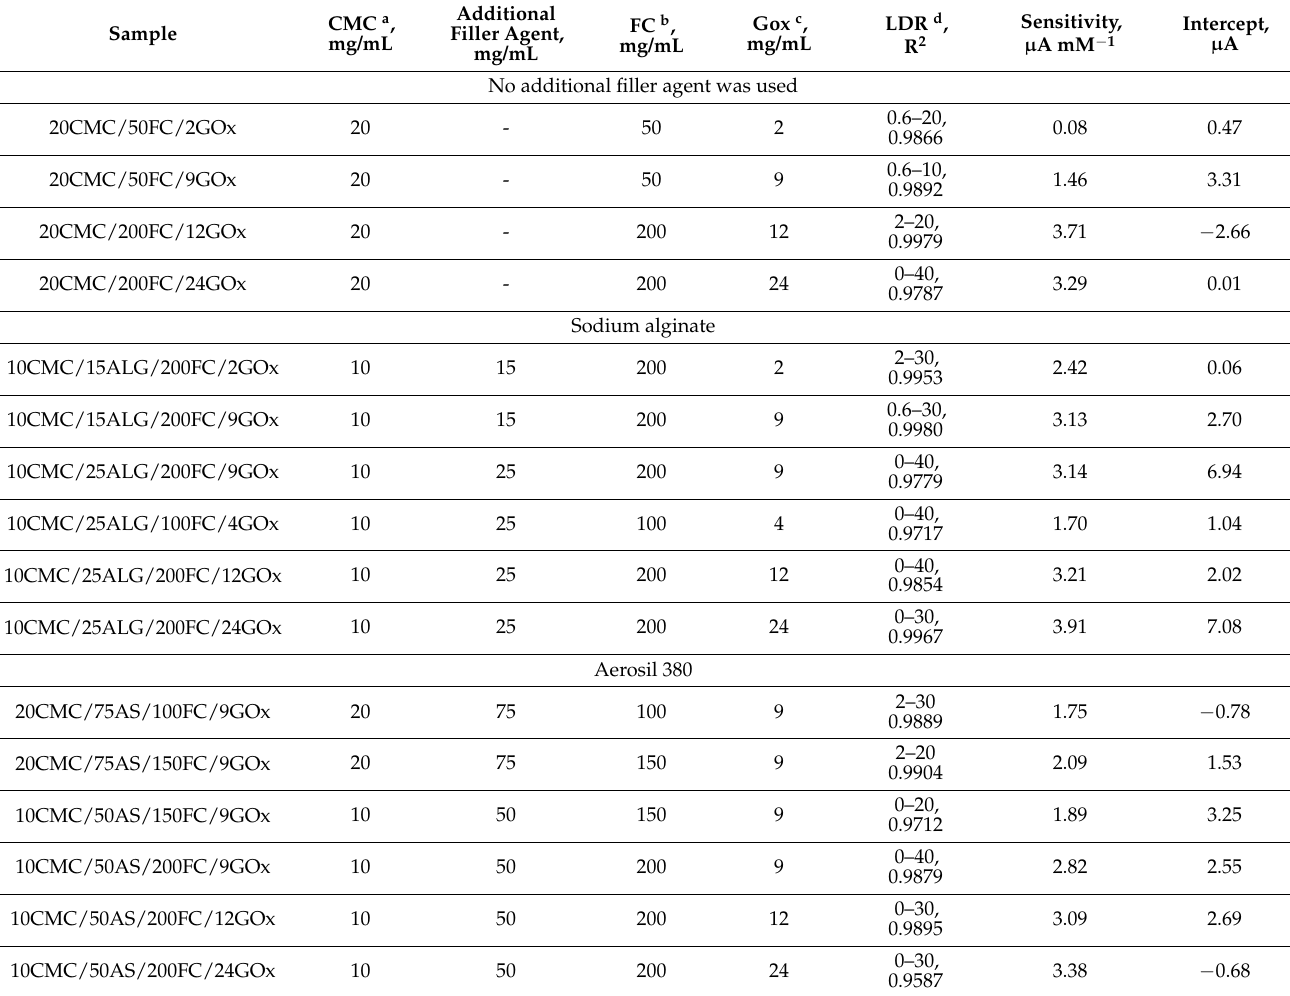
Table 1. Comparison of analytical merit of glucose test strips in dependence on the gel composition used for the functional layer preparation in 0.1 M citrate buffer, pH